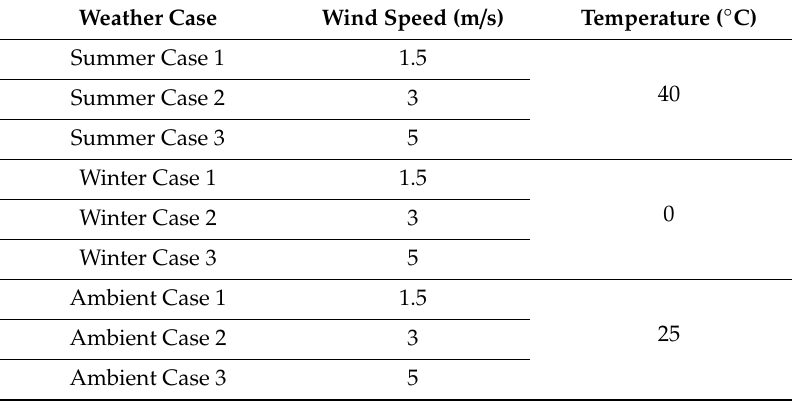
Table 6. Wind speed and atmospheric stability applied to simulations in summer (40 ◦ C) and winter (0 ◦ C) conditions.